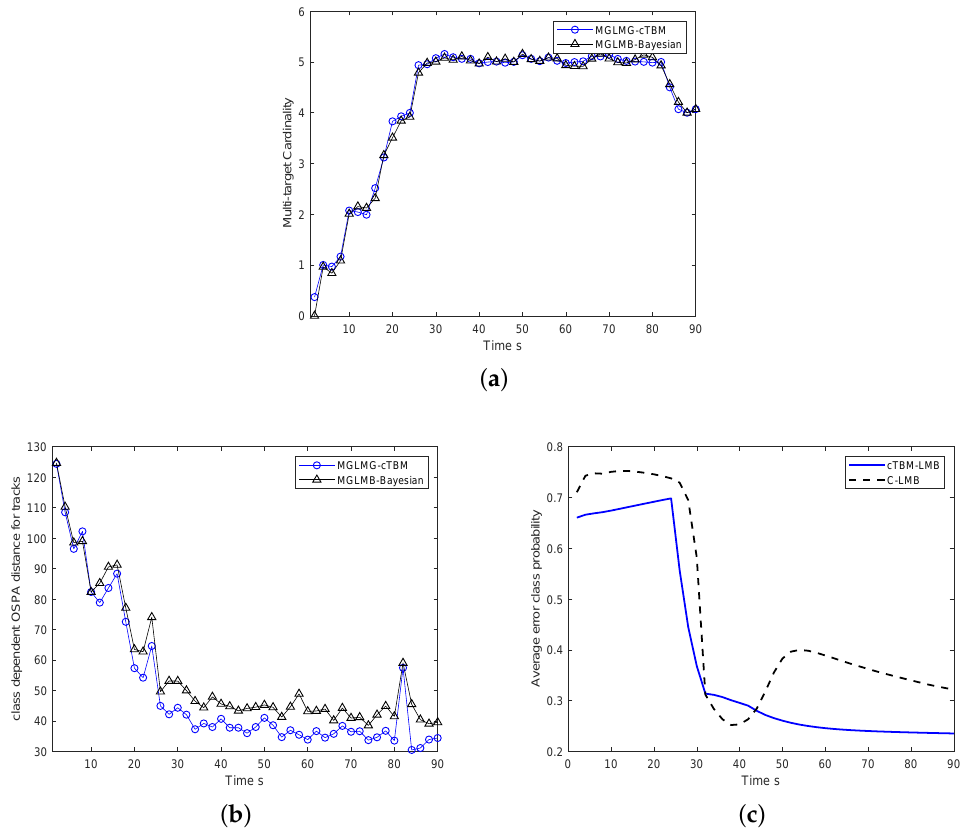
Figure 8. The comparison of tracking and classification results between multi-model marginal generalized labeled multi-Bernoulli (MGLMB)-Bayesian and MGLMB-cTBM; ( a ) cardinality estimates, ( b ) overall tracking performance, ( c ) average error class